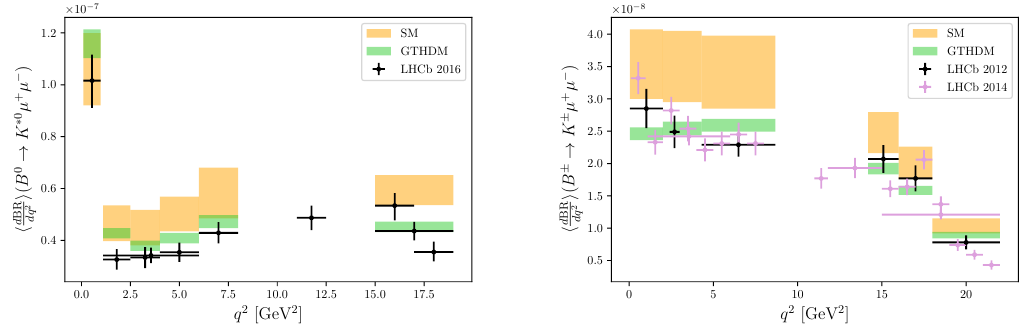
( B 0 → K ∗ 0 µ + µ − ) with the LHCb 2016 dq 2